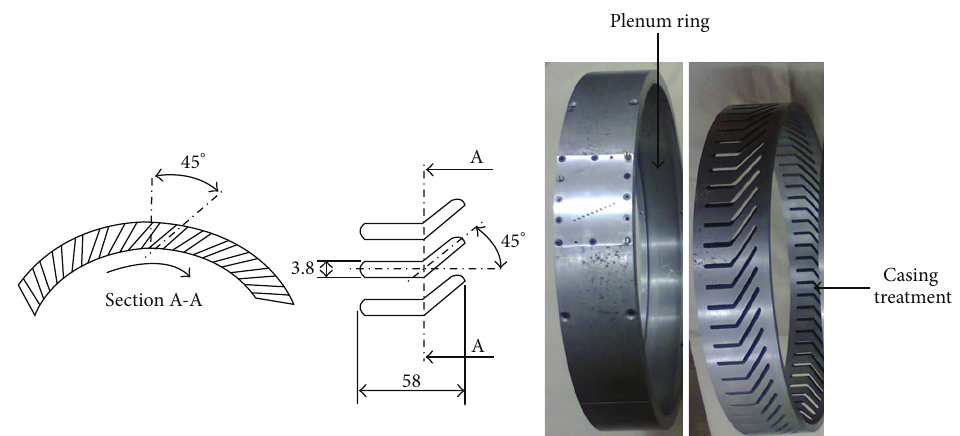
Figure 2: Schematic and photograph of the casing treatment and plenum chamber